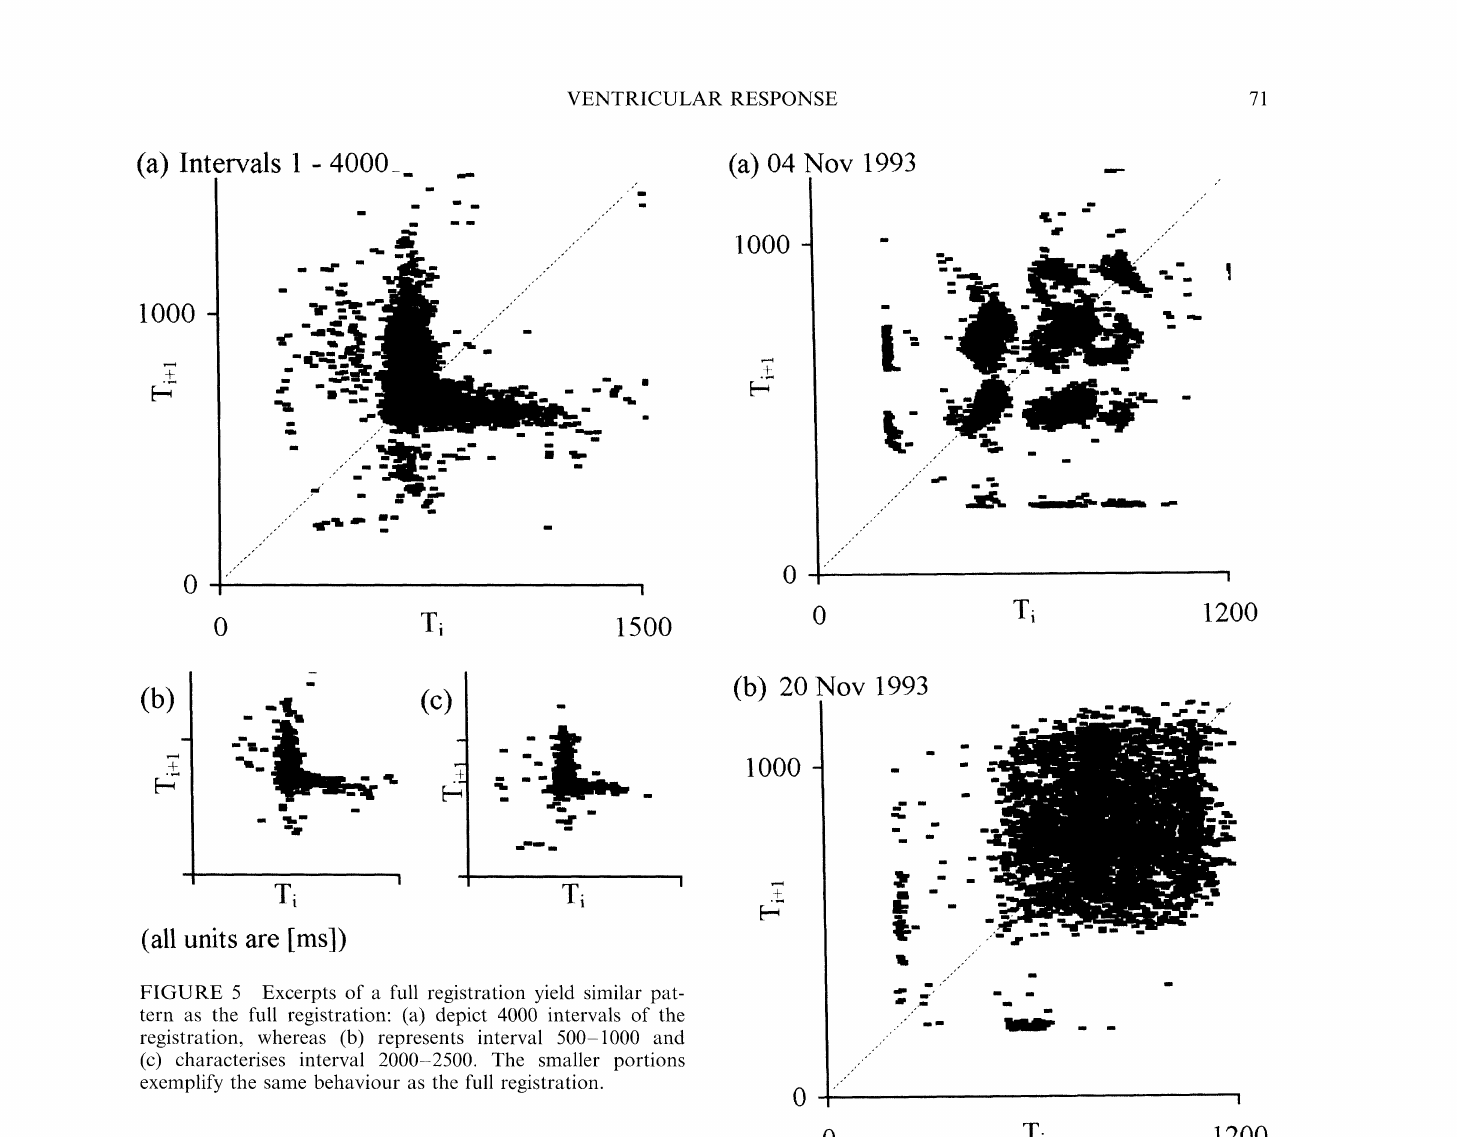
FIGURE 6 Occurrences which change the cardiac entity alter the appearance of the Poincar&plots: (a) is a registration prior to cardiac surgery which the patient underwent on the 12 Nov 1993; (b) shows the different aspect of the resulting plot. Both times the ECG diagnosis was atrial